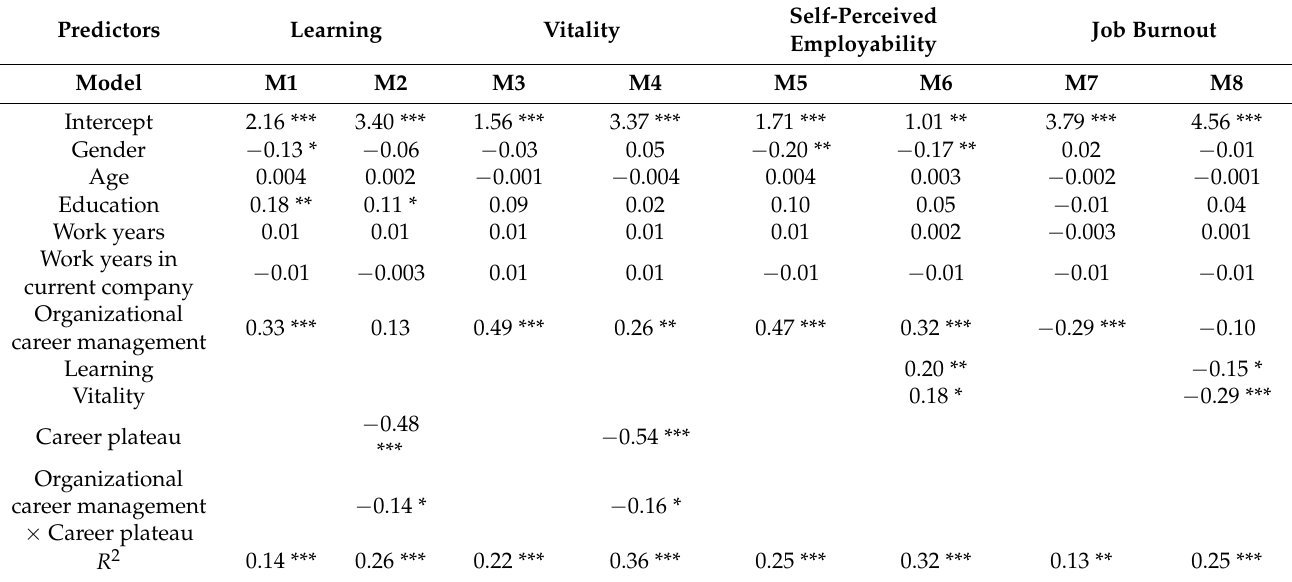
Table 3. Results of regression analysis.